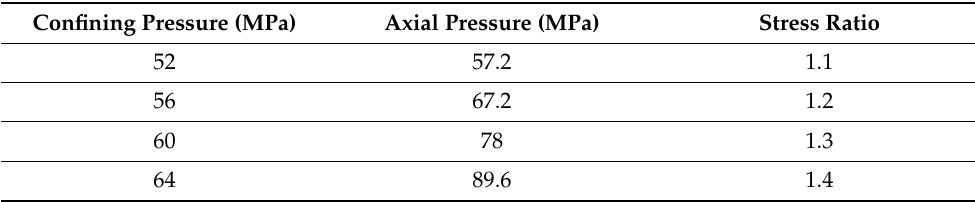
Table 2. The experimental scheme table. Confining Pressure (MPa) Axial Pressure (MPa)